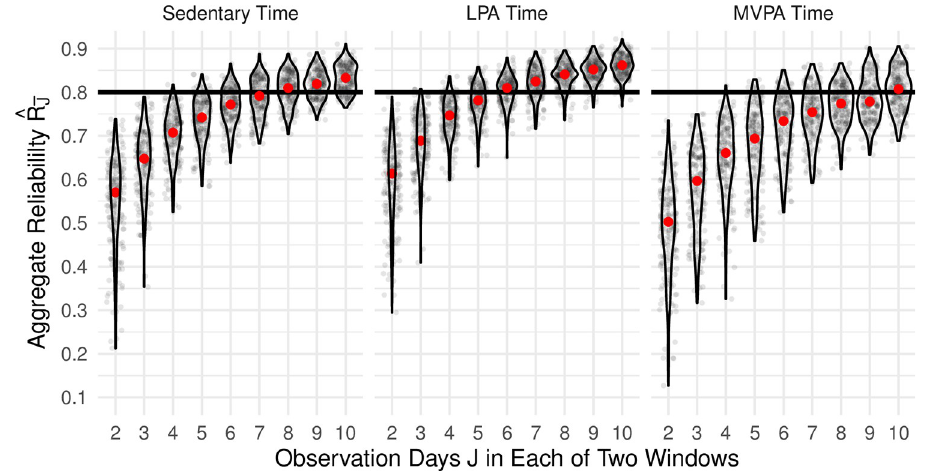
Fig 4. Direct estimation of aggregate reliability. Results of the investigation into aggregate reliability of the average daily activity for each activity metric, estimated as the test-retest reliability (intraclass correlation) of the averages from two separate periods of between 2 and 10 days selected for each participant. The solid red circle indicates the median across 200 sampled datasets.